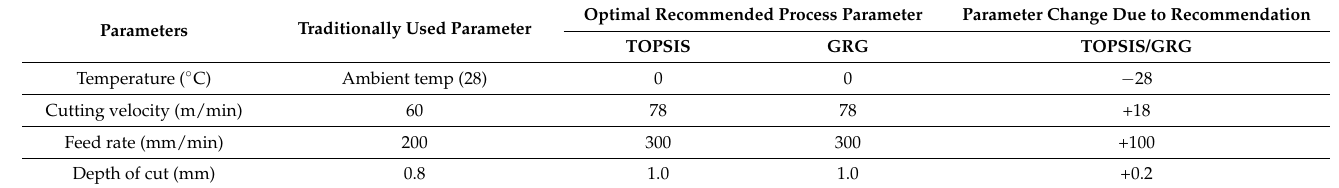
Table 10. Comparison of optimized parameters obtained by TOPSIS and GRG methods with conven- tionally used parameters.